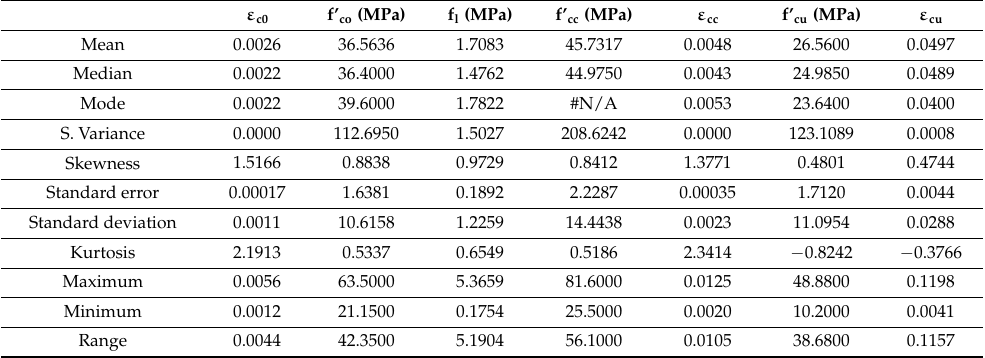
Table 2. Descriptive statistics of the variables used in the model development based on 42